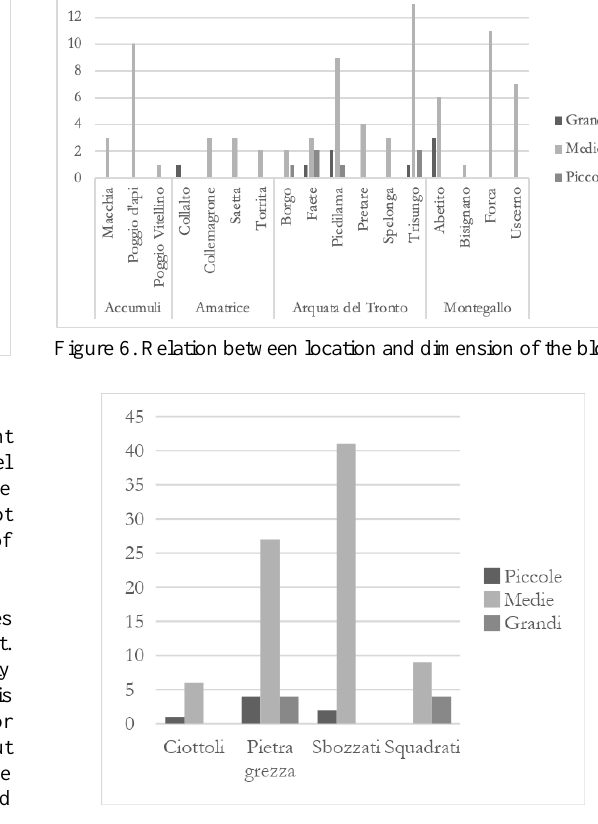
Figure 7. Relation between dimension and shape.